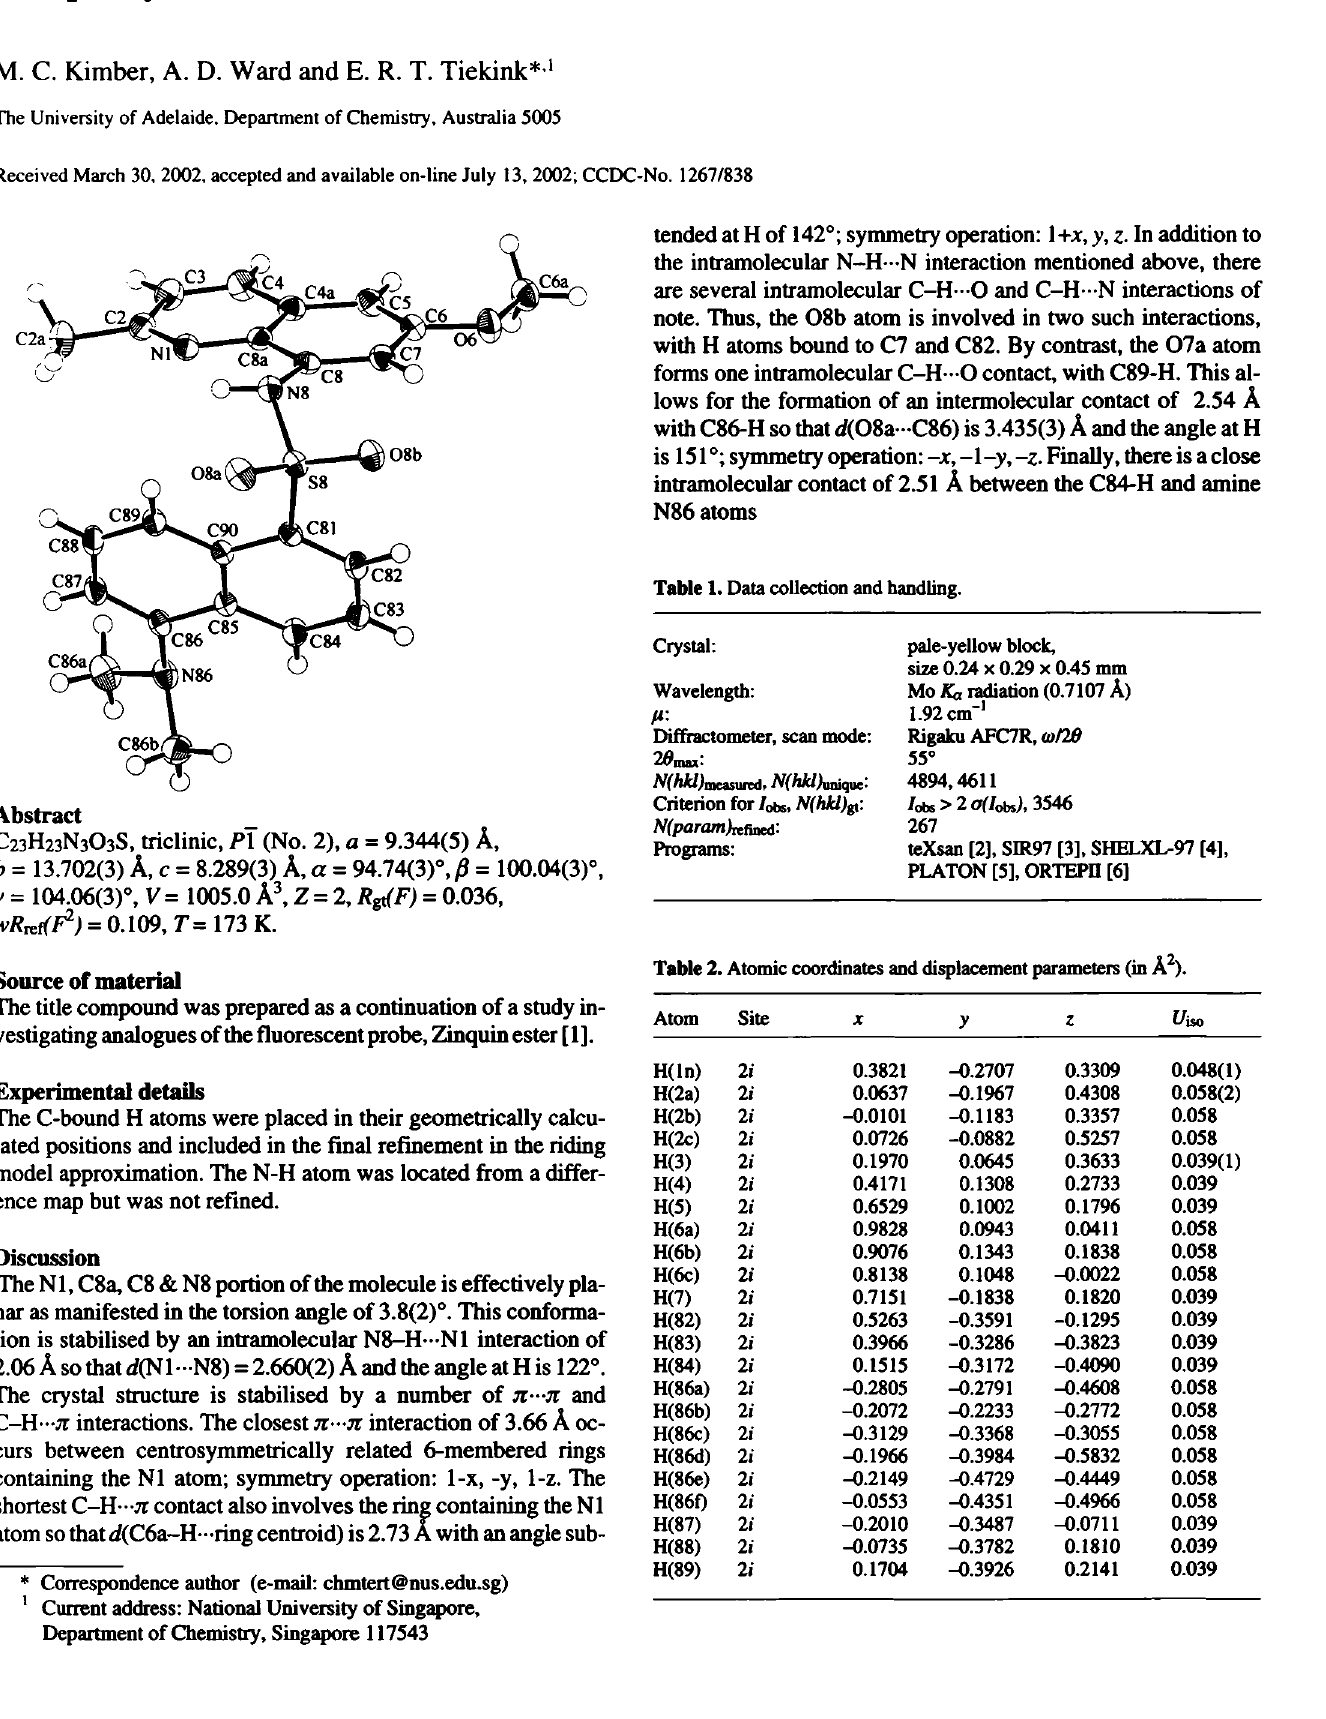
Table 2. Atomic coordinates and displacement parameters (in Â 2